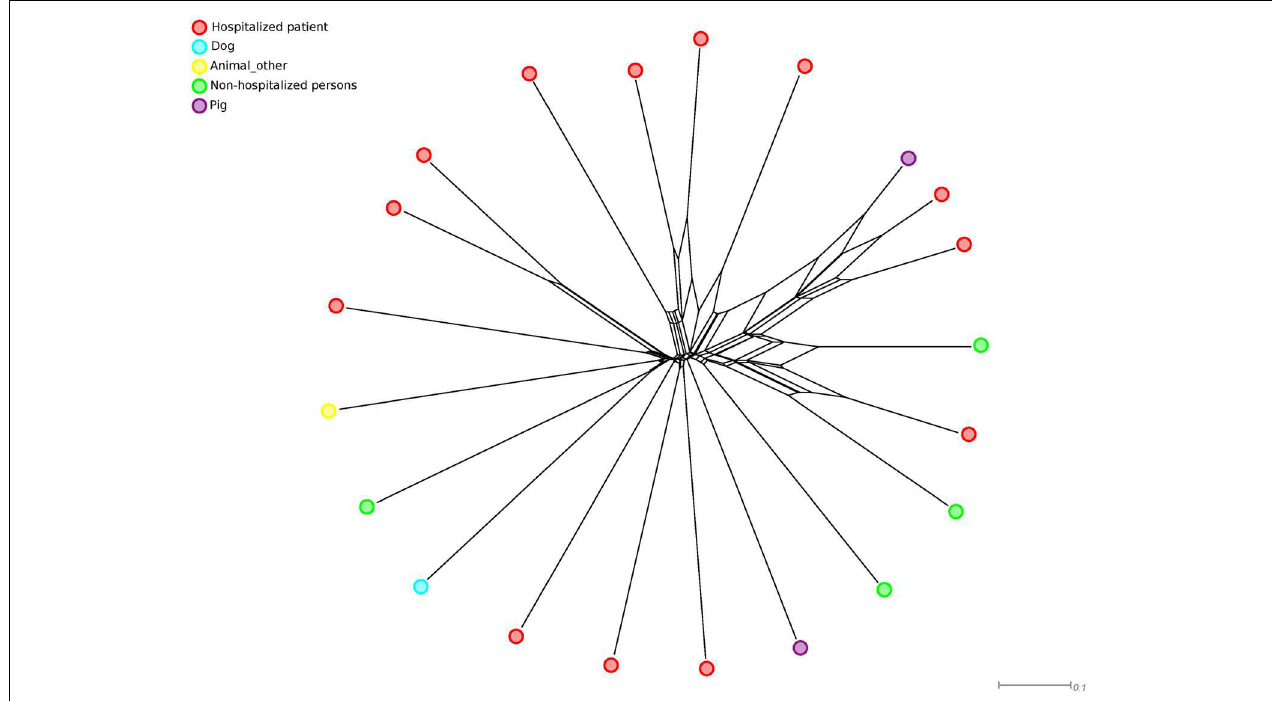
FIGURE 2 | NeighborNet phylogenetic network to visualize the relationships between 21 E. faecalis isolates. The distance matrix underlying the network was built from all pairwise allelic profile comparisons of 1298 loci of an ad hoc E. faecalis cgMLST scheme using SeqSphere (http://www.ridom.de/seqsphere/). Small colored circles indicate the origin of